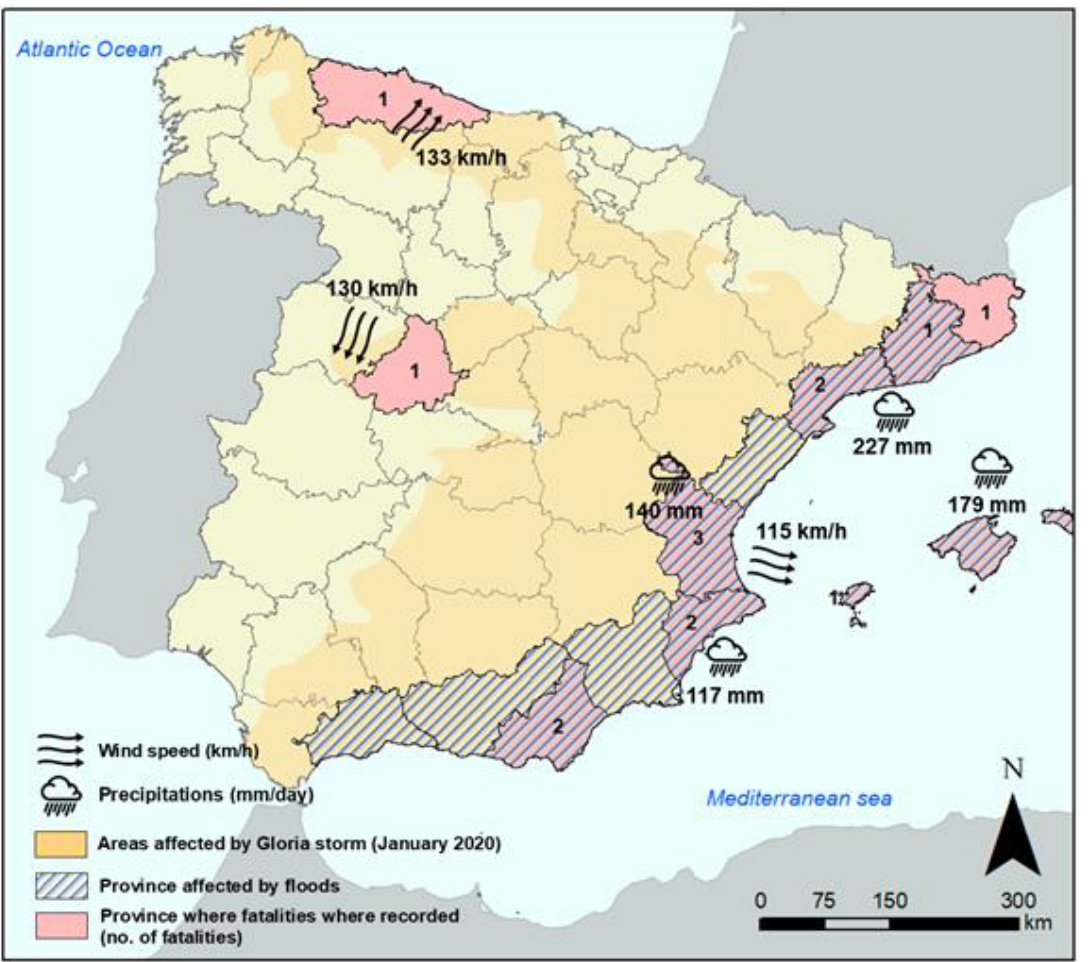
Figure 5. Impacts of Storm Gloria (January 2020) in Spain. Fatalities are located by provinces. Gloria set a milestone in the Mediterranean coast of Spain, breaking records of snow thickness, wave thickness and intense rainfall. Data from [36,37].